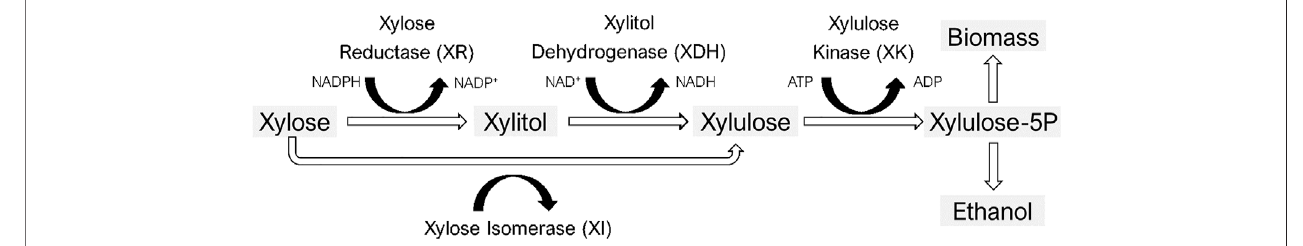
FIGURE 1 | Xylose assimilation pathway in yeasts (Albuquerque et al.,